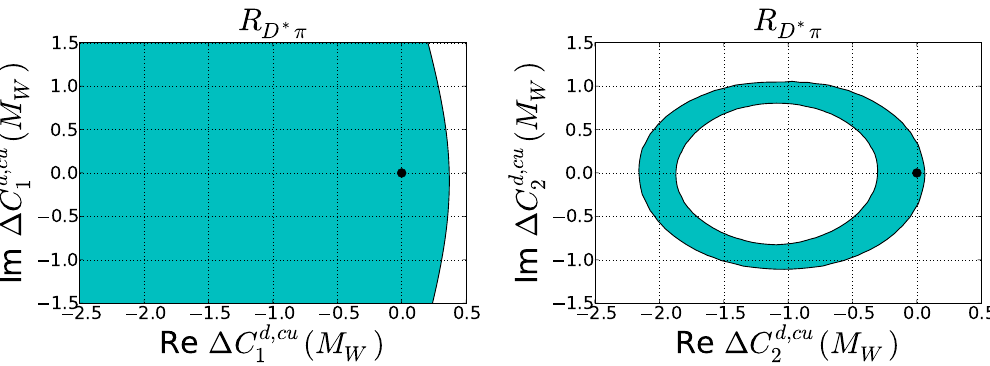
Figure 6 . Potential regions for the NP contributions in (cid:1) C d;cu